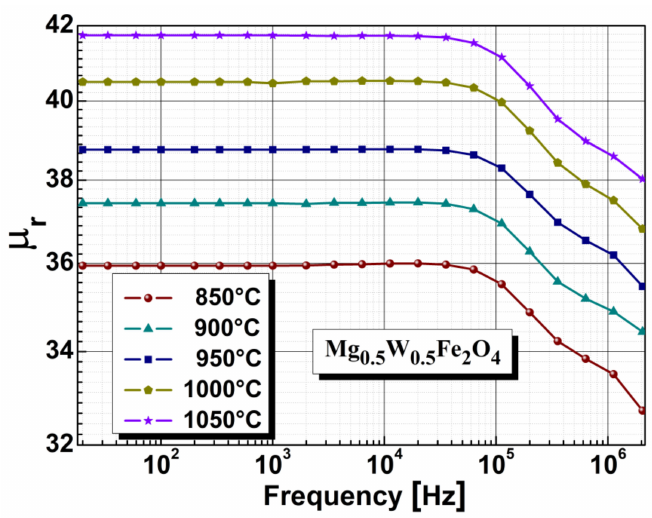
Figure 5. The influence of annealing temperature on the relative permeability characteristics of Mg 0.5 W 0.5 Fe 2 O 4